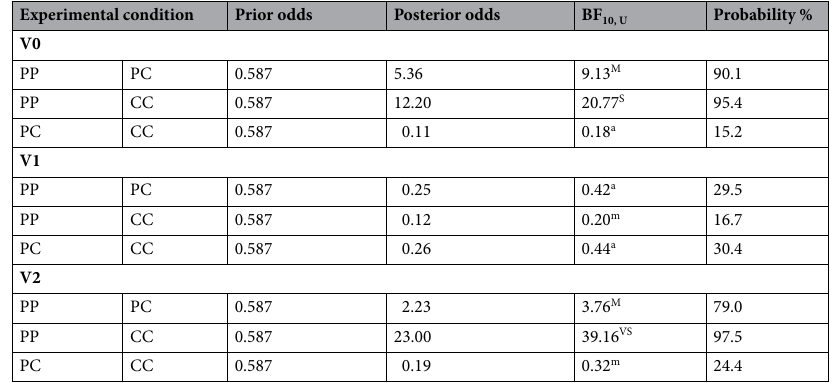
Table 4. Bayesian analysis for the comparison of symbolic analysis parameters among caffeine supplementation conditions. The posterior odds have been corrected for multiple testing by fixing to 0.5 the prior probability that the null hypothesis holds across all comparisons (Westfall, Johnson, & Utts, 1997). Individual comparisons are based on the default t test with a Cauchy (0, r = 1/sqrt(2)) prior. The “U” in the Bayes factor denotes that it is uncorrected (PP: Placebo–Placebo; PC: Placebo–Caffeine; CC: Caffeine– Caffeine). Letters indicate the outcome classified as: A = anecdotal; M = moderate; V = very strong; E = extreme favoring the alternative hypothesis; a = anecdotal; m = moderate favoring the null